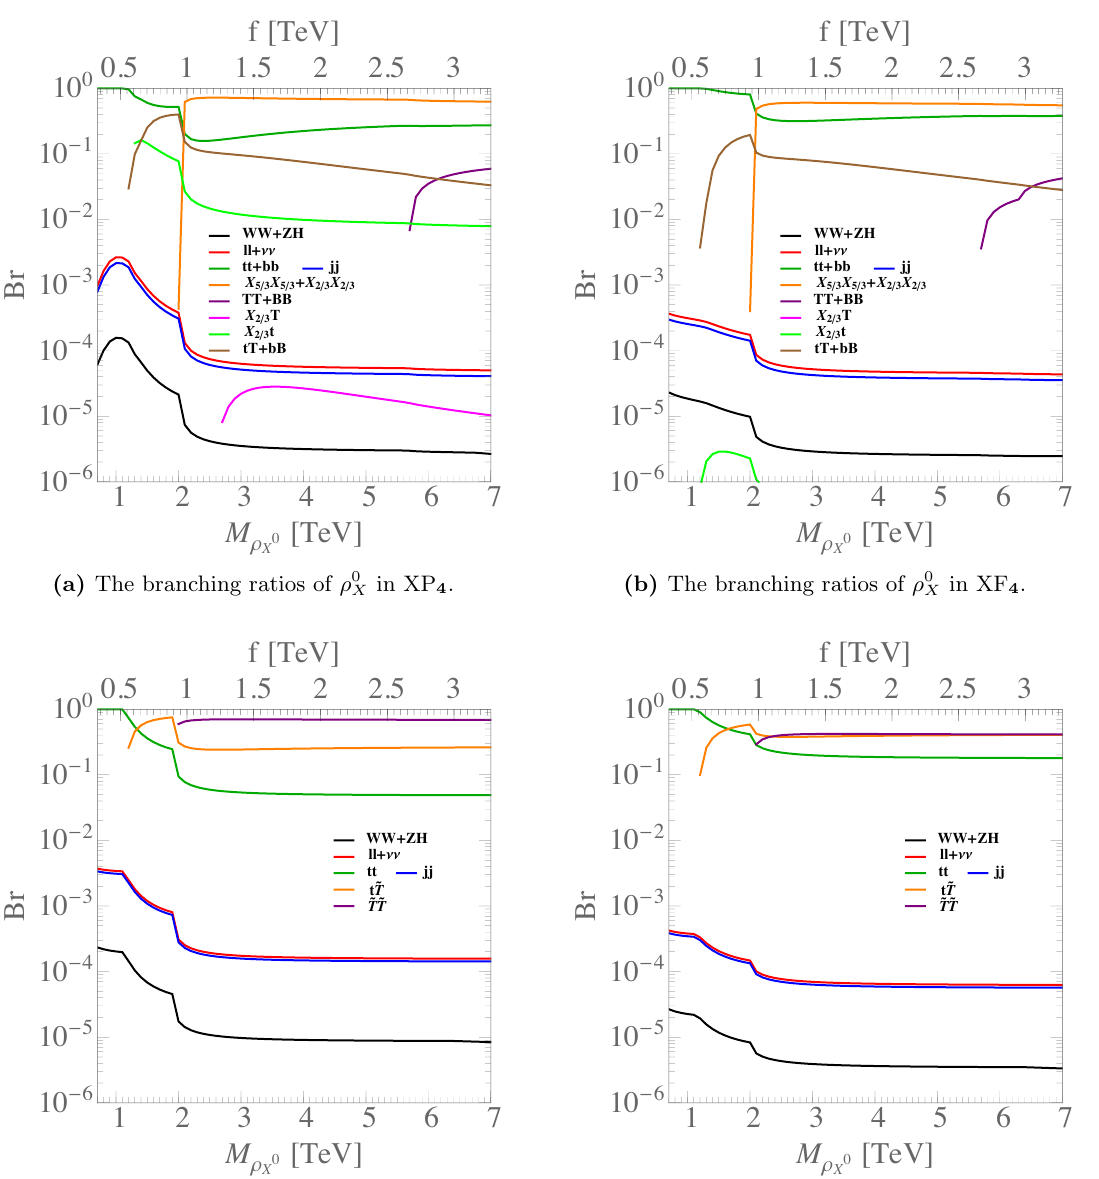
(c) The branching ratios of (cid:26) 0